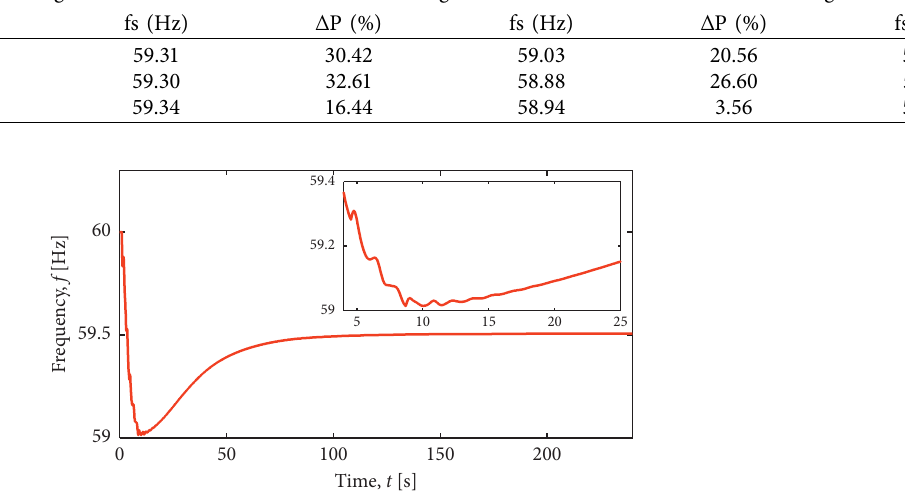
Figure 10: Frequency response after the activation of the UF-relays by the disconnection of generator G06. Table 4: Optimal settings of UF-relays by using the PSO algorithm.